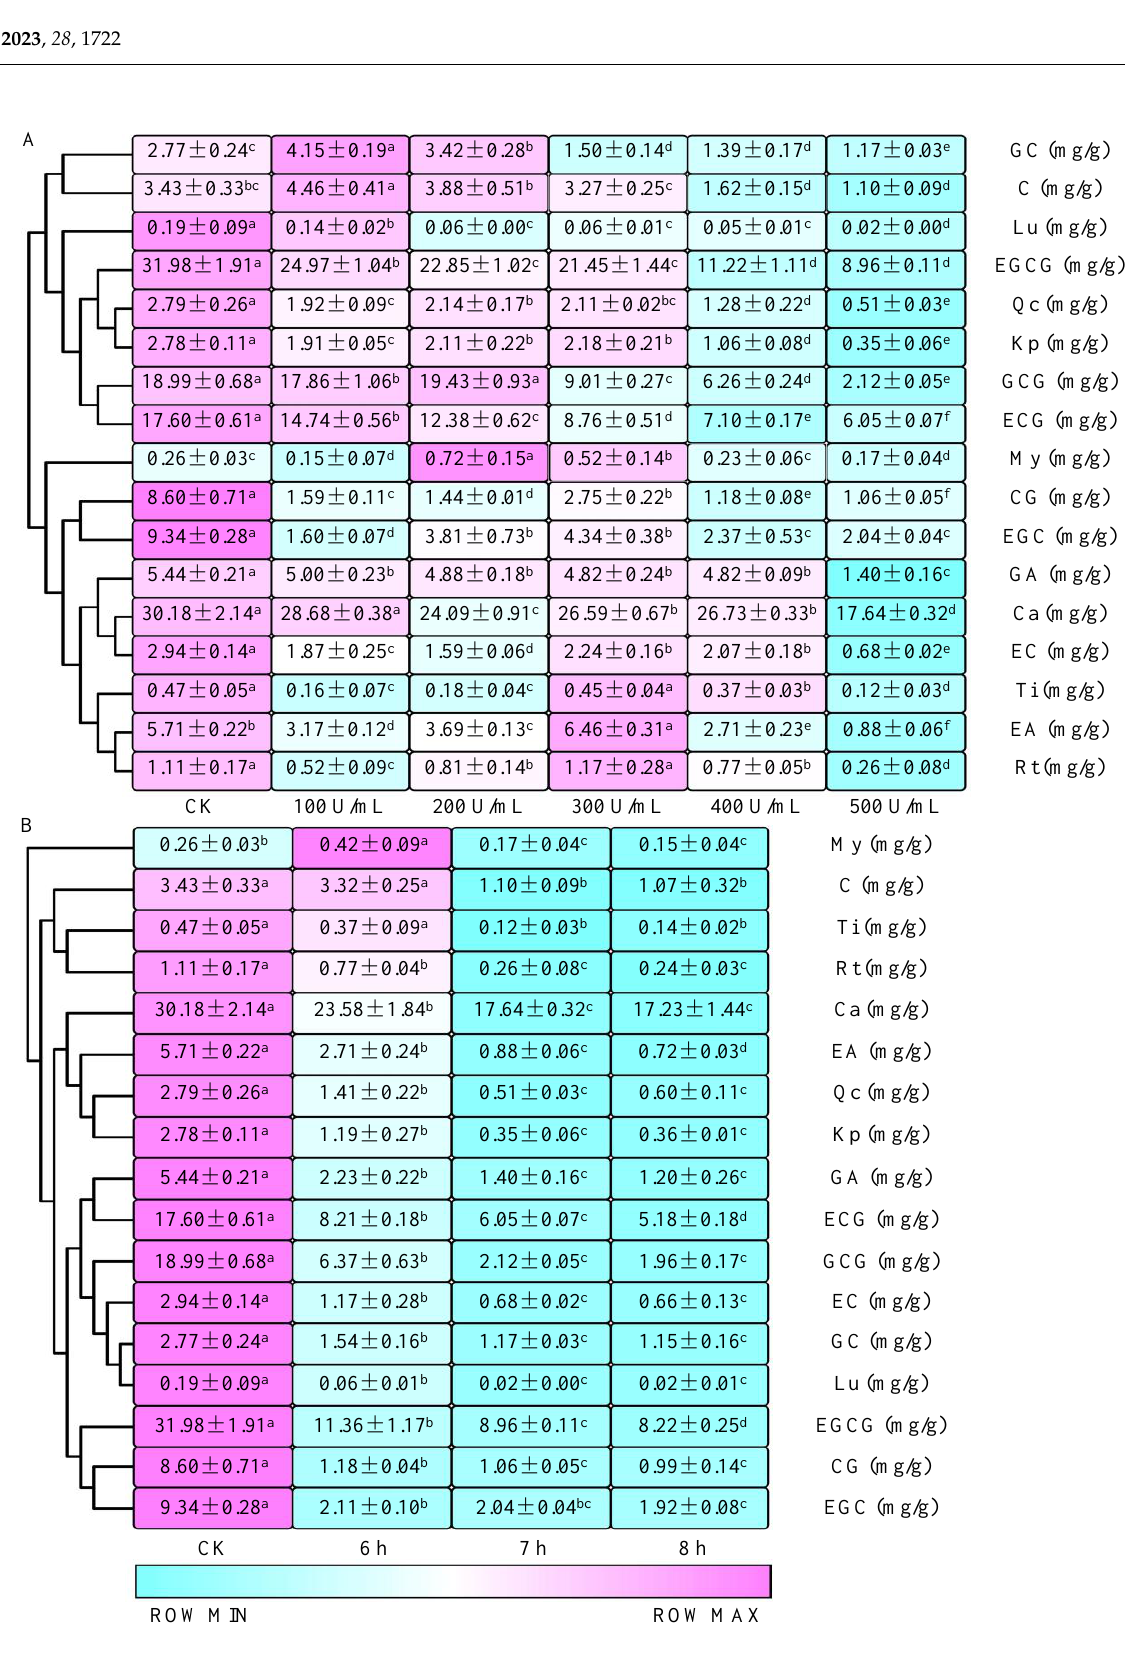
Figure 1. The catalysis of TPs in sun-dried green tea leaves using different concentrations ( A ) and with different reaction times of PPO ( B ). Different lowercase superscripts within a row indicated significantly different among comparisons ( p <